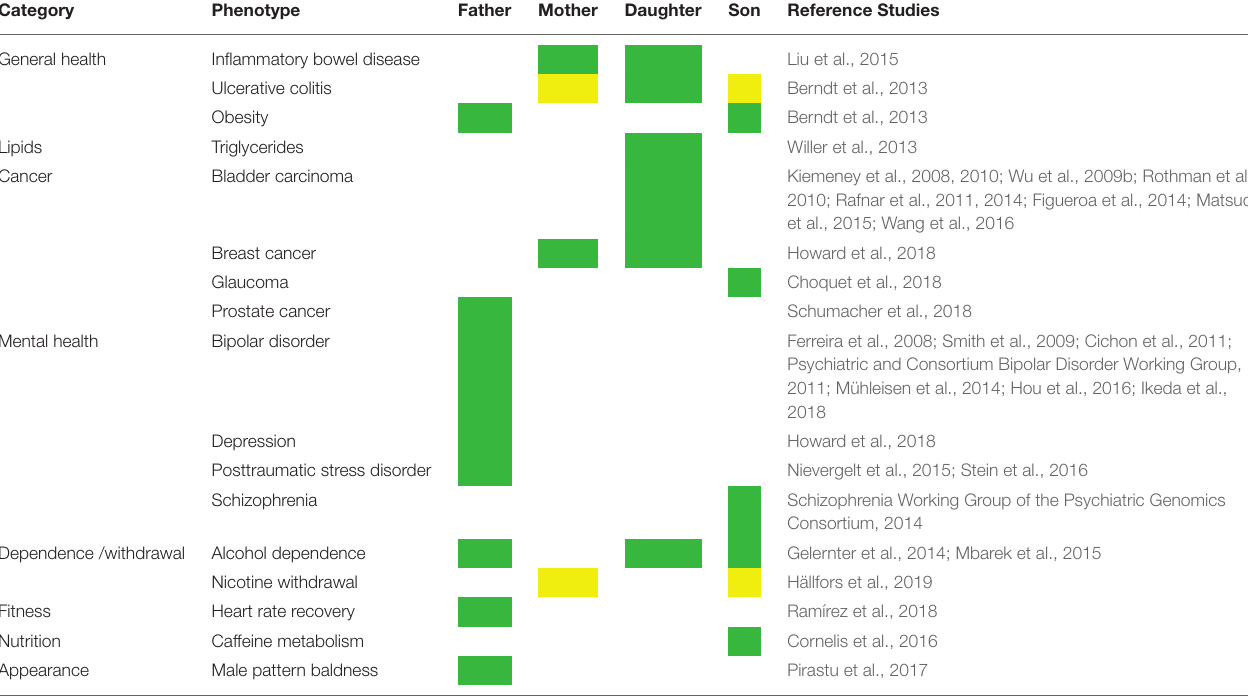
TABLE 5 | Phenotypes for family members with < 1SD genetic risk